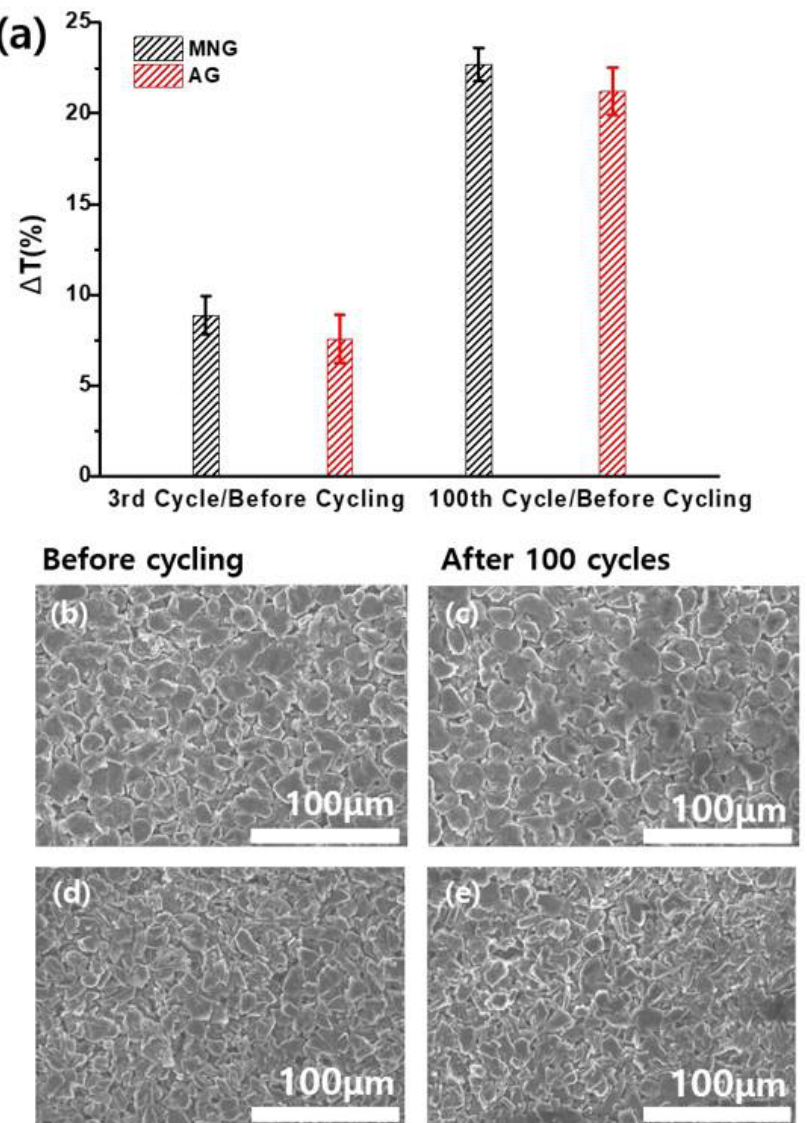
Figure 10. ( a ) Electrode thickness change after 100 cycles for modified spherical natural graphite (MNG), artificial graphite (AG), and electrode surface SEM image of ( b , c ) MNG and ( d , e ) AG.